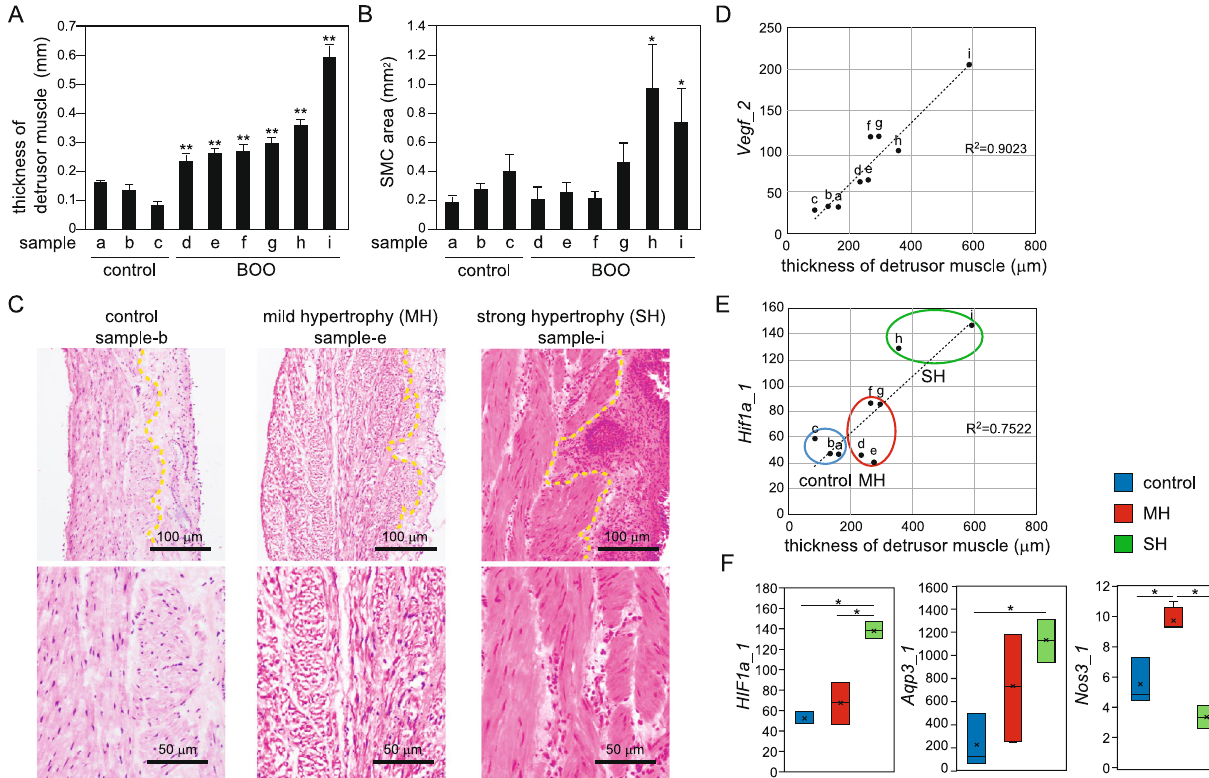
Figure 1. Expression patterns of genes related to hypoxia and urinary function in three experimental groups. ( A ) The thickness of the detrusor muscle in rats in the BOO model. Tissue thickness is shown as the average of 6 spots with a distance of 0.1 mm in the extra layer of muscle. Control rats underwent sham operation. Data are means ± SEM. A significant deferent test for sample- a is shown. ** P < 0.01. ( B ) Cell area of smooth muscle in the BOO model rats. Number of cell nuclei in a single muscle bundle and the area of muscle bundle were measured using ImageJ. [The muscle bundle area/number of cross-sectional nuclei] was calculated and shown as the average of 4 bundles. Data are means ± SEM. A significant deferent test for sample- c is shown. * P < 0.05. ( C ) HE staining of the urinary bladder tissue in rats in the BOO model. HE stained images are data of samples shown in Fig. 1A and 1B. Yellow dotted lines in upper panels show borders between smooth muscle and lamina propria. Bottom panels show magnification of the detrusor muscle from each upper panel. All images are obtained using AdvanView 3.7 imaging software included in AdvanCam-E3Rs/ALL-IN-ONE system (http:// advan- vision. com). ( D ) Correlations between Vegf levels and the thickness of the detrusor muscle in each rat (n = 9). Vegf mRNA levels were quantified using RNA-seq (TPM counts are shown on the vertical axis). Tissue thickness is the average value of 6 spots in the extra layer of muscle (horizontal axis). The letters above each dot corresponds to sample name in Fig. ( A ) and ( B ). ( E ) Correlations between Hif1α levels and the thickness of the detrusor muscle in each rat. ( F ) Expression patterns of genes related to urinary function in the control, MH, and SH groups. For each box plot, the box represents the 25th to 75th percentile interval, and the line represents the median. The cross mark represents average. Top or bottom of bar extending from the box represents the maximum or minimum, respectively. * P <